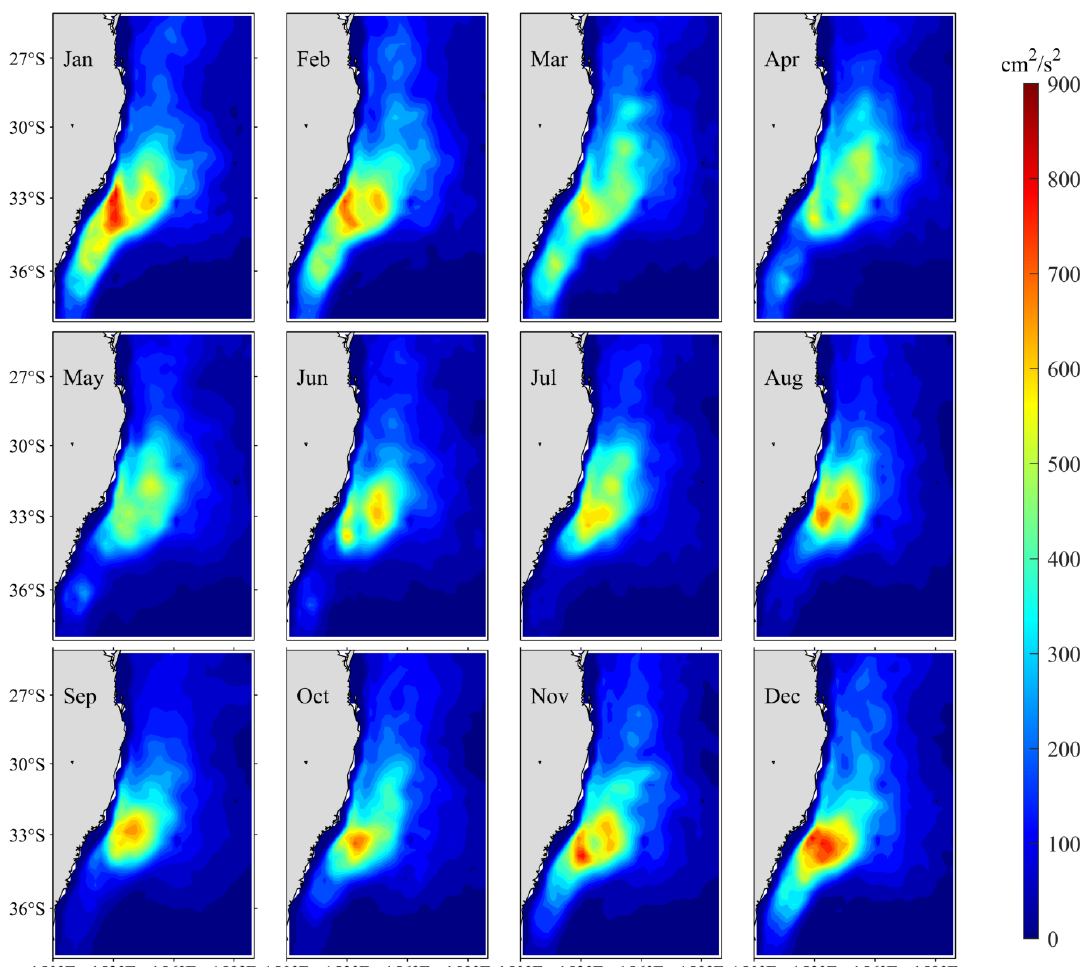
Figure 6. Monthly mean climatological EKE distributions in the upper 500 m layer. Here EKE is calculated from the 60–180-day bandpass filtered velocity data from the ECCO2 (1992–2019).